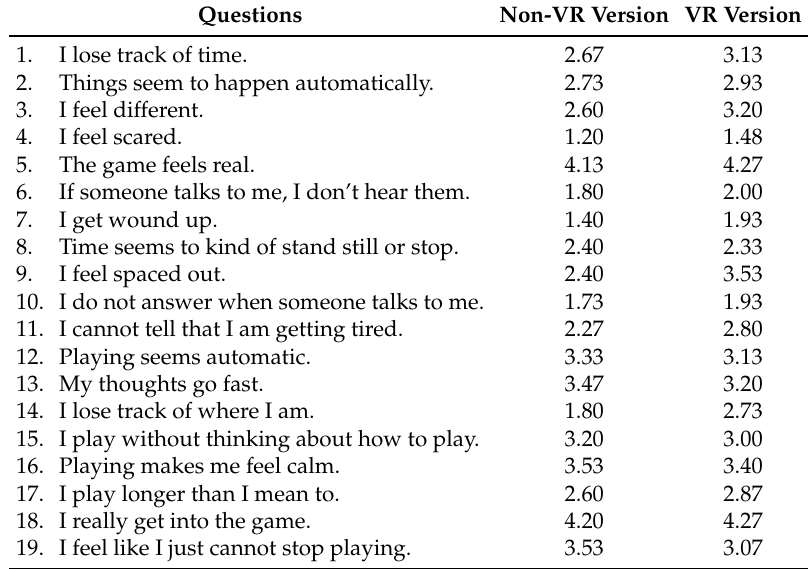
Table 1. Game Engagement Questionnaire (GEQ) items [5] and the results of the game engagement evaluation. The rating scale for each GEQ item is 1 (strongly disagree) to 5 (strongly agree).